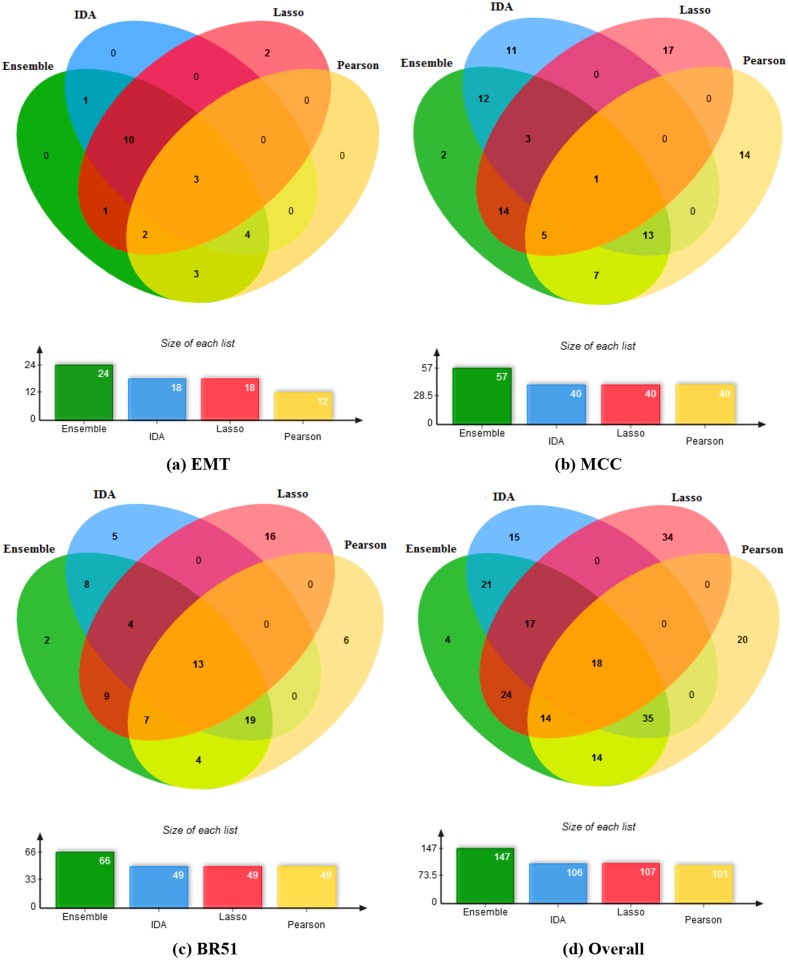
Venn diagram of the number of confirmed miRNA-mRNA interactions for the best ensemble method (Pearson+IDA+Lasso) and each individual method (Pearson, IDA and Lasso).For each miRNA, we extract top 200 target genes ranked by each method for validation.